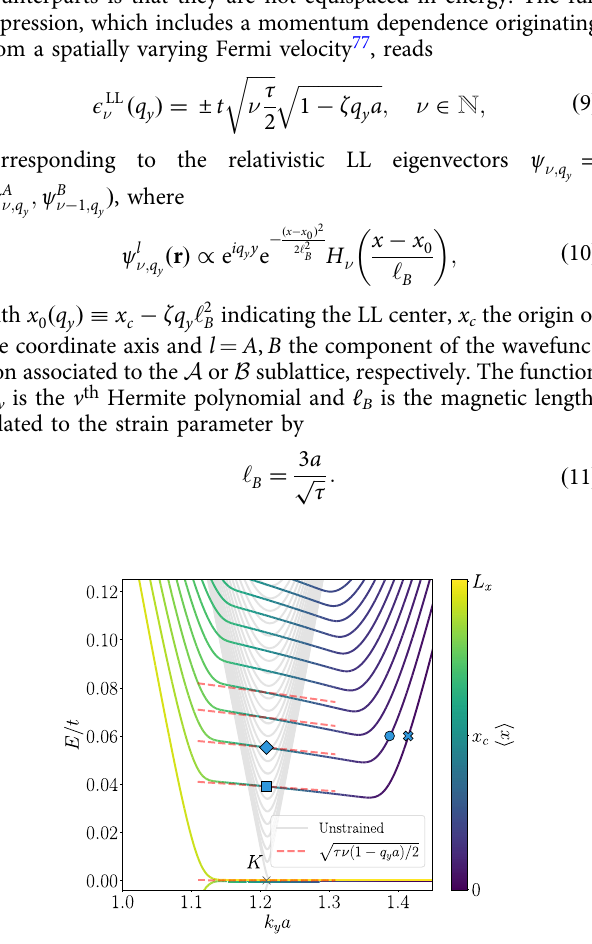
Fig. 2 Landau levels in the honeycomb lattice for uniaxial strain. Energy spectrum of ^ H 0 for N x = 601 sites, and strain strengths τ = 0 (in light gray) and τ = 0.003 (gradient of colors). In the strained case, the color represents the mean position 〈 x 〉 of each eigenstate. The four dots with different markers indicate to representative eigenvectors of the corresponding energy branch that will be shown in a separate fi gure. The red dashed lines represent analytical predictions of the fi rst fi ve Landau levels ( ν = 1, . . . , 5). The parameter a denotes the lattice